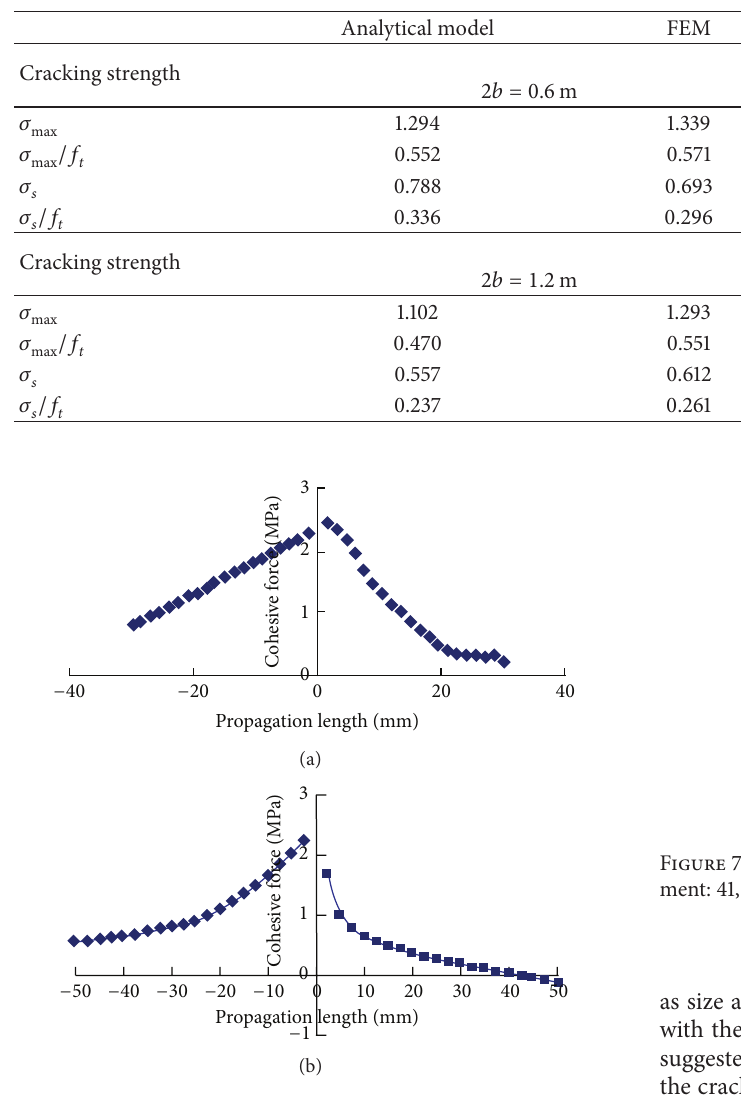
Figure 6: Tangential stress distribution near the crack tip: (a) the subcritical point under maximum load and (b) an unstable propagation point.